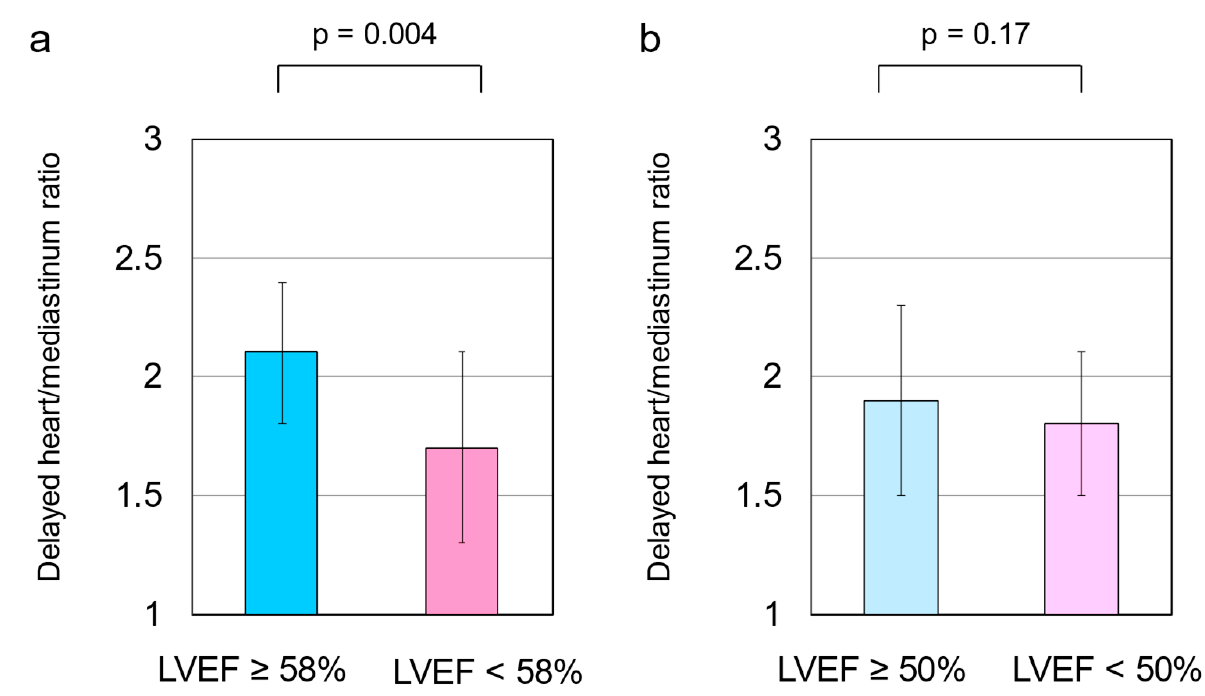
Figure 1. ( a ) The delayed heart/mediastinum (H/M) ratio was significantly higher in patients with a left ventricular ejection fraction (LVEF) of ≥ 58% than in those with an LVEF of <58% (2.1 ± 0.3 vs. 1.7 ± 0.4, p = 0.004). ( b ) When divided into two groups using an LVEF of 50%, no significant differences were found in the delayed H/M ratio between the two groups (1.9 ± 0.4 vs. 1.8 ± 0.3, p = 0.17). These data were compared using an unpaired Student’s t -test.